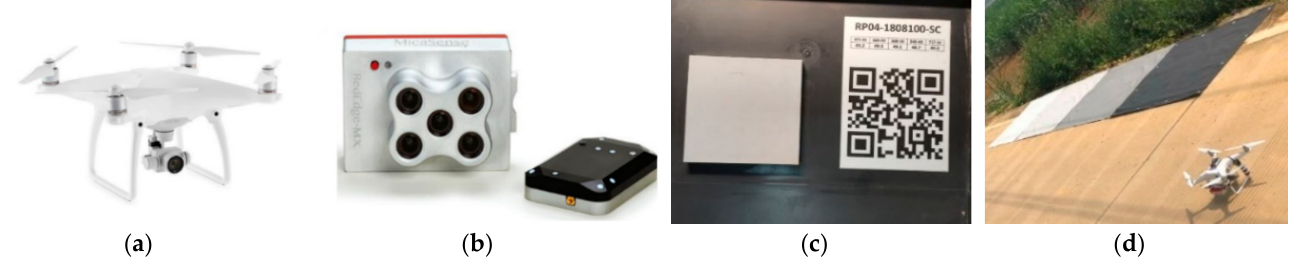
Figure 3. The image acquisition system. ( a ) DJI Phantom 4 Pro; ( b ) RedEdge-MX multispectral image sensor; ( c ) reflectance correction panel of RedEdge-MX; and ( d ) calibration tarps.